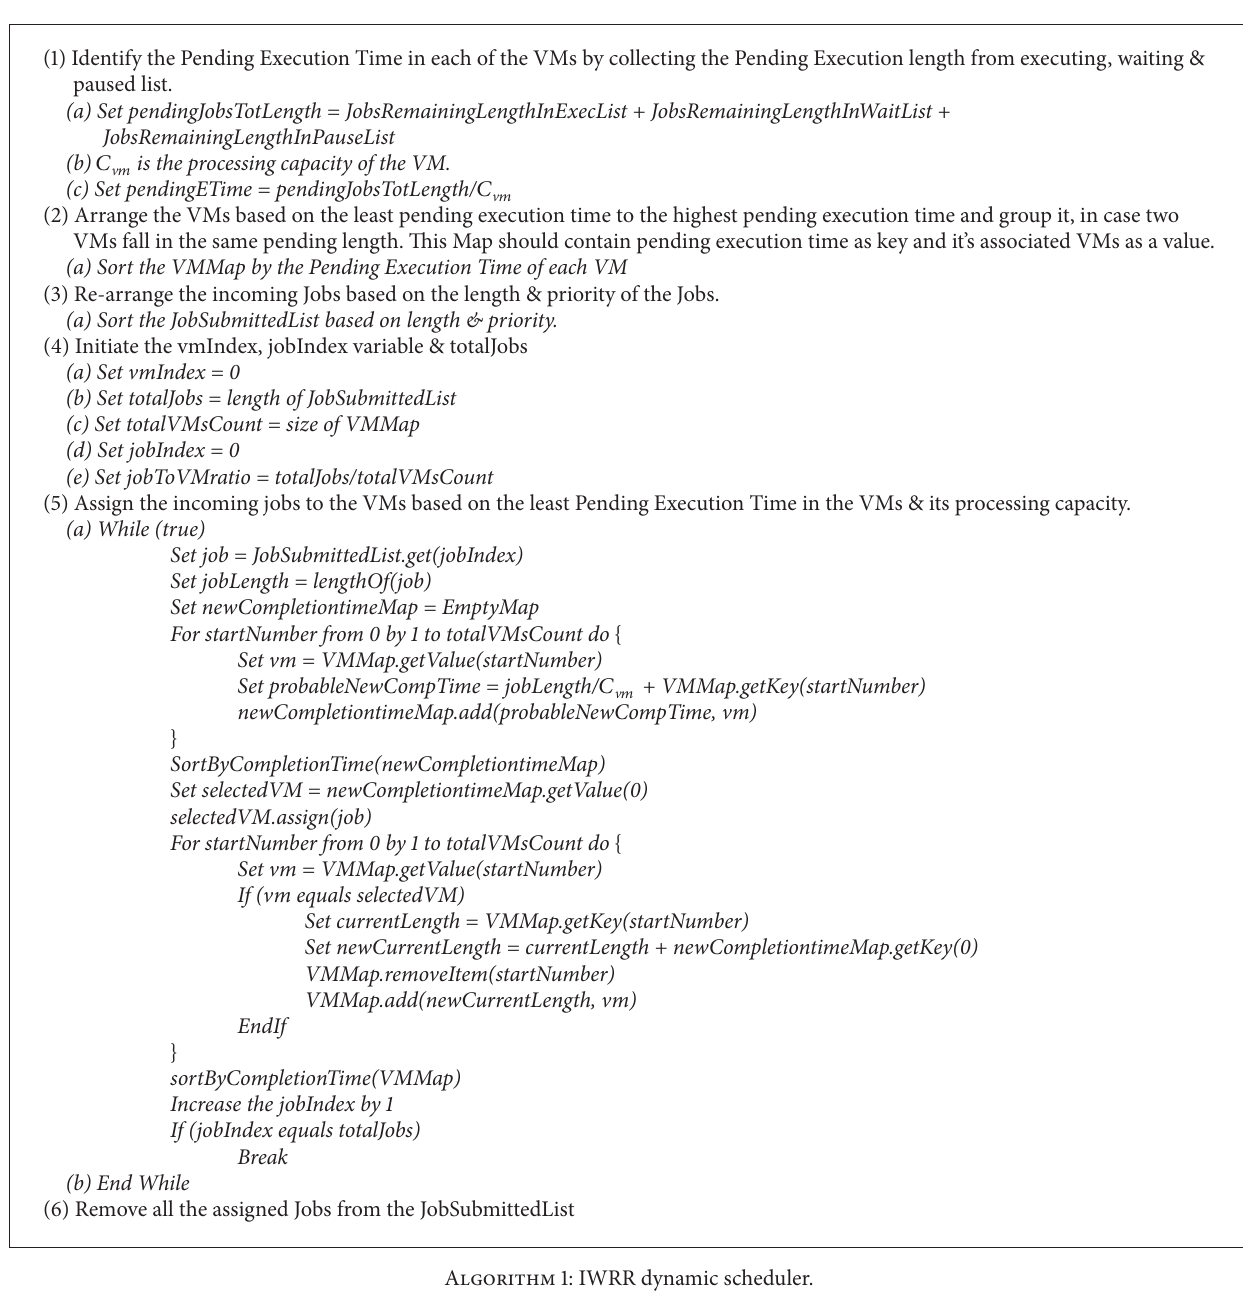
Algorithm 1: IWRR dynamic